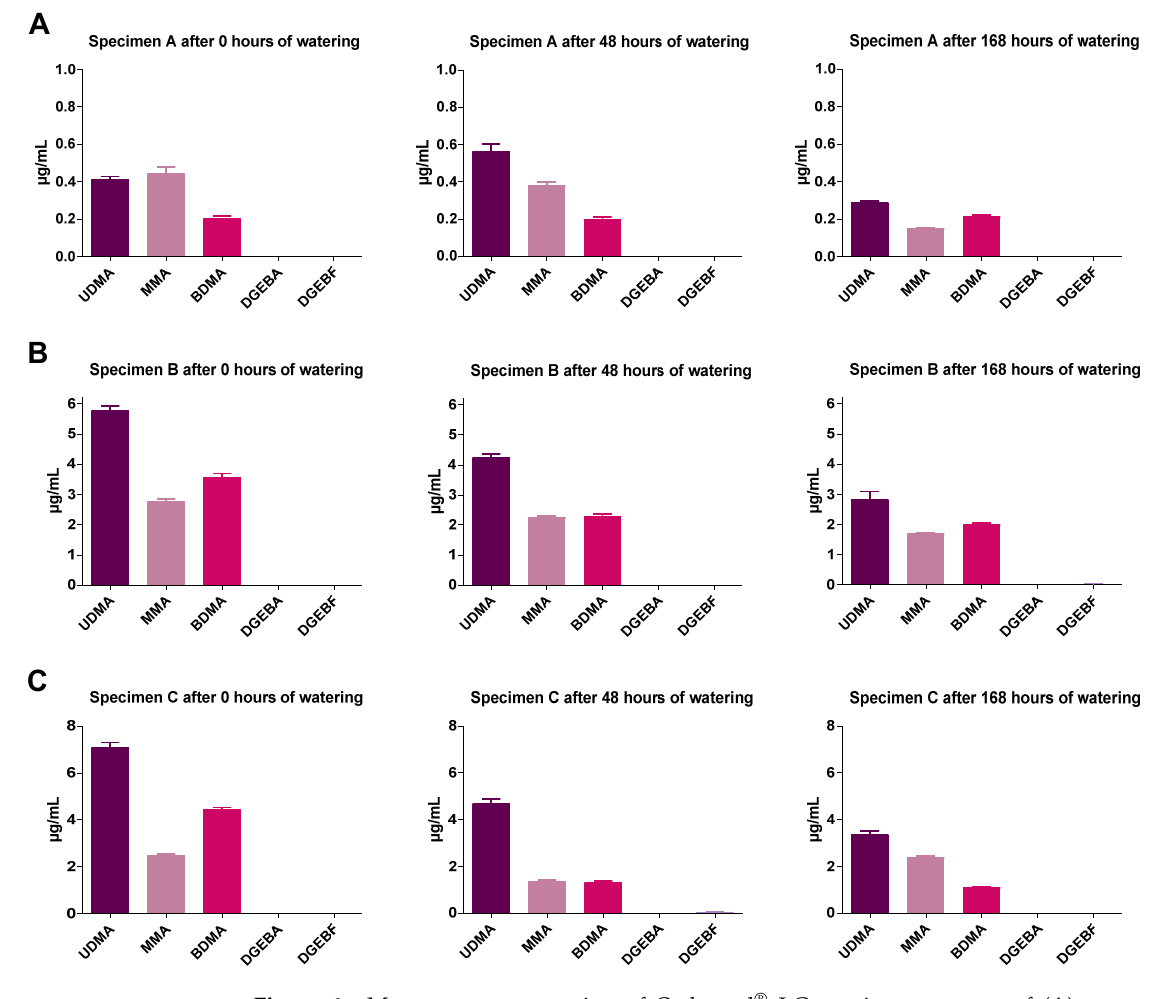
Figure 6. Monomer concentration of Orthocryl ® LC specimen extracts of ( A ) test specimens A (15 mm × 0.5 mm), ( B ) test specimens B (50 mm × 1.0 mm), or ( C ) test specimens C (50 mm × 3.0 mm) under different soaking conditions. The test specimens were stored in distilled water at room temperature for 0, 48 or 168 h followed by a 24 h storage in cell culture medium (DMEM, Dulbecco’s Modified Eagle Medium) under shaking conditions. The DMEM eluates were used undiluted (100%) to determine the monomers by GC-MS. UDMA, urethane dimethacrylate; MMA, methyl methacrylate; BDMA, 1,4-butanediol dimethacrylate; DGEBA, bisphenol A diglycidyl ether; DGEBF, bisphenol F diglycidyl ether. The data are mean values ± SEM of n = 3–4 per